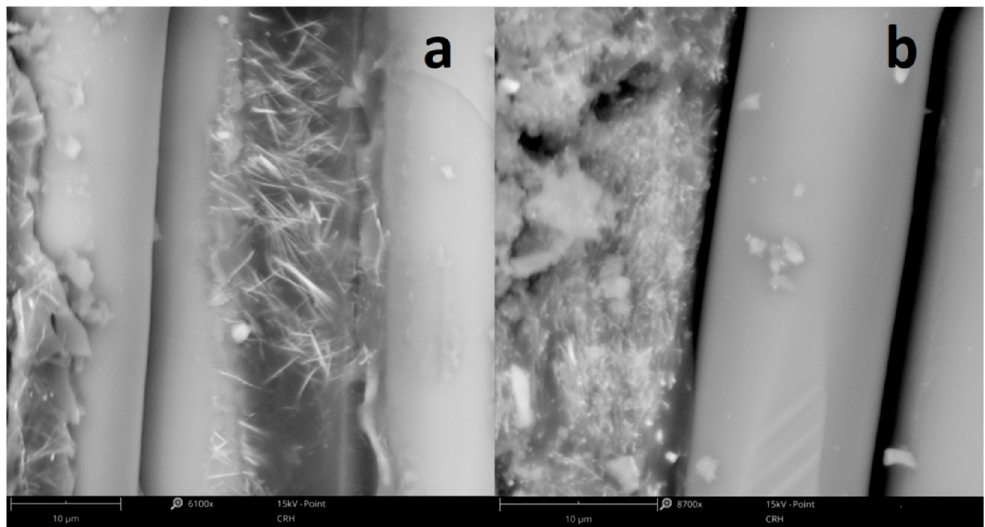
Figure 5. SEM micrographs of FRP laminate with ( a ) 20% and ( b ) 40% of SbSI nanowires weight concentration showing the boundary between the epoxy resin-SbSI nanowires composite and glass-fiber reinforcement.